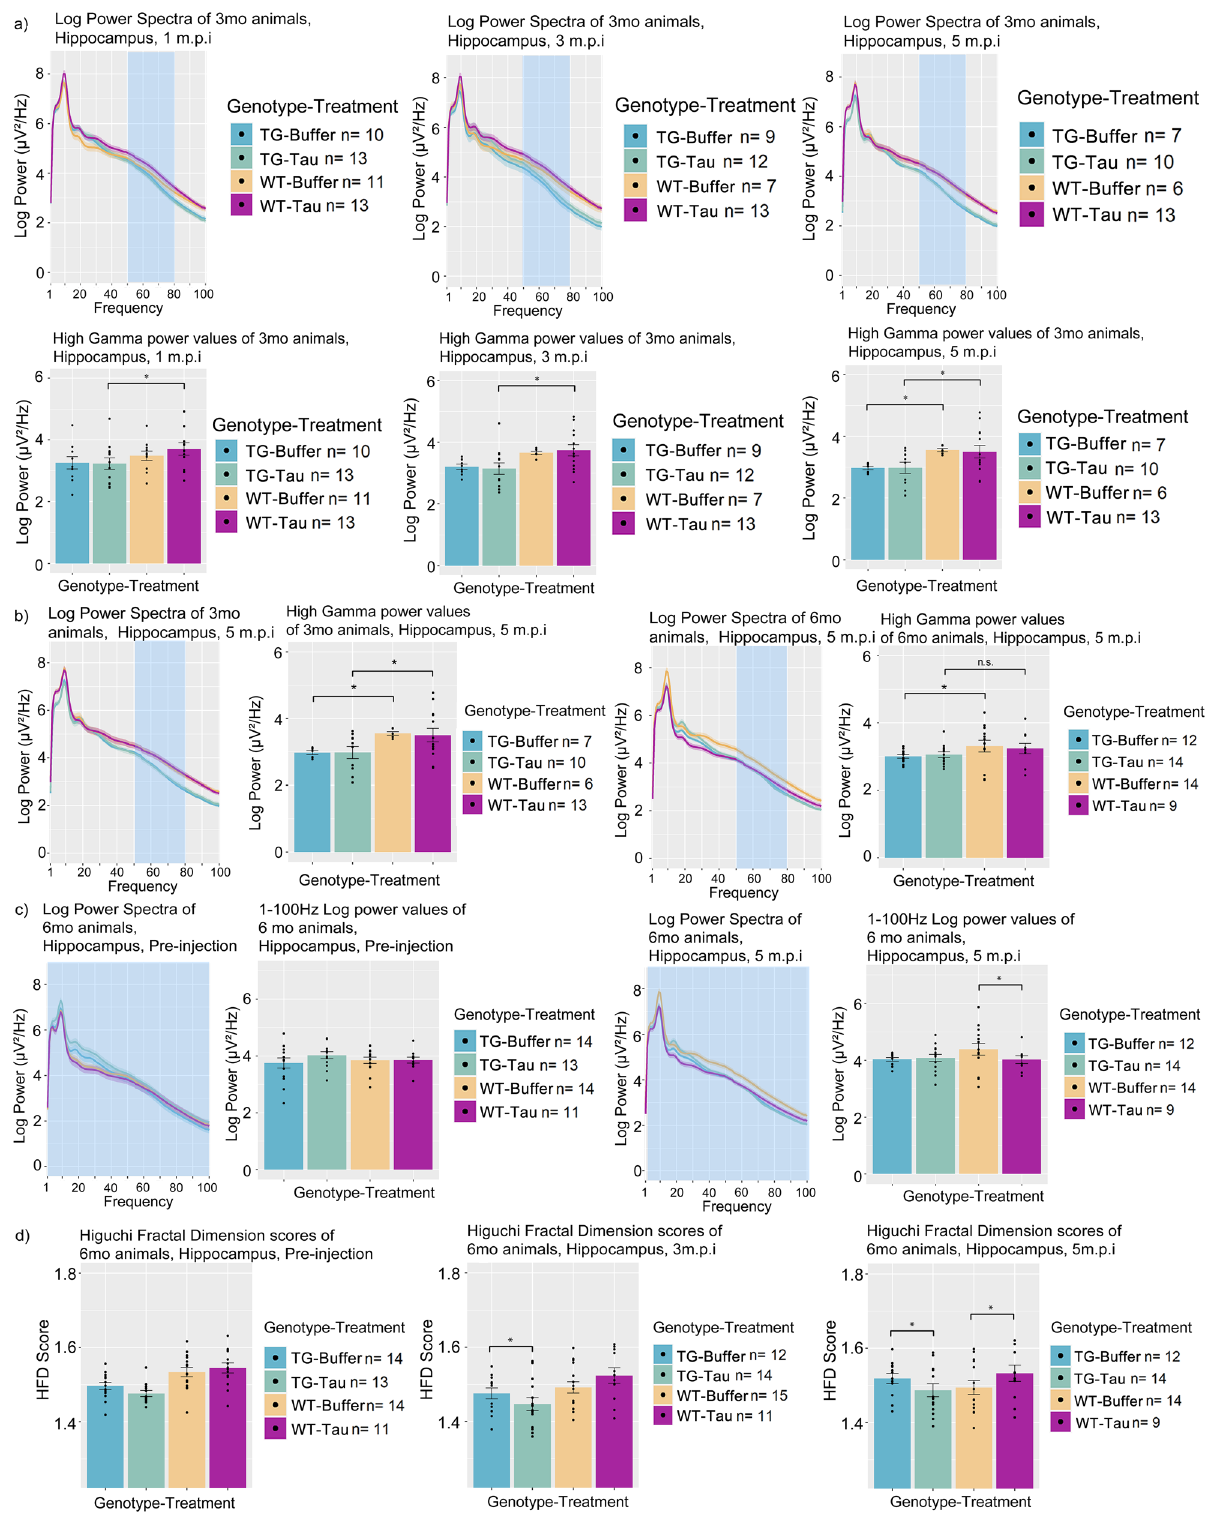
Figure 6. Longitudinal power spectra comparisons and Higuchi fractal dimension score comparisons ( a ) Log power spectra and accompanying bar plots from 3-month-old animals showing longitudinal change in high gamma power across 5 m.p.i. and treatment-genotype groups. Blue regions indicate the region of the power spectra used for the plotting of bar plots. ( b ) Bar plot comparisons of 3-month-old and 6-month-old animals for high gamma power. ( c ) Whole power spectra (1-100 Hz) comparison between 6-month-old animals at 5 m.p.i. and pre-injection. ( d ) Higuchi fractal dimension score bar plots of the hippocampus of 6-month-old animals at pre-injection, 3 and 5 m.p.i. (m.p.i. refers to months post injection). All bar plots are Mean + SEM. Asterisks indicate significant comparisons ( p <